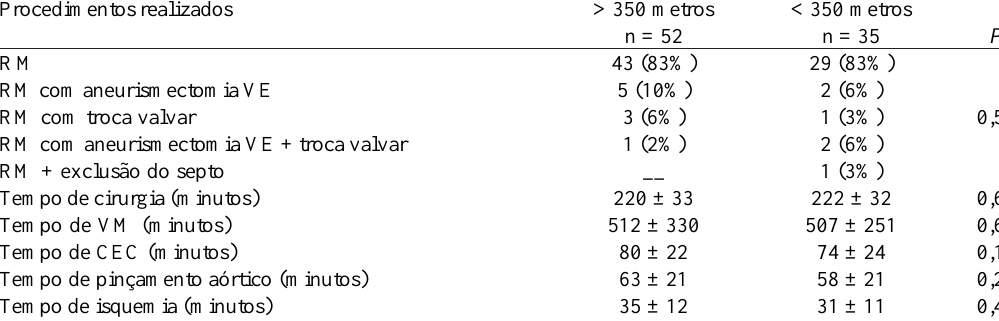
Tabela 3. Dados intra e